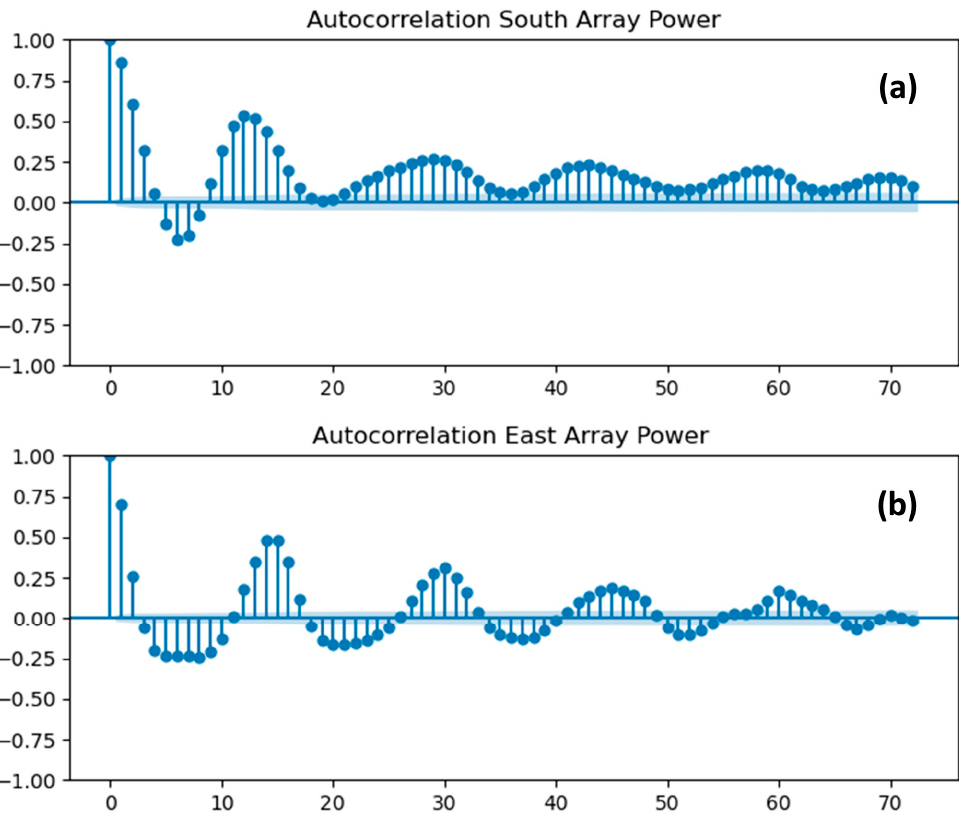
Figure 3. Autocorrelation plots for the array power: ( a ) South array. ( b ) East array.